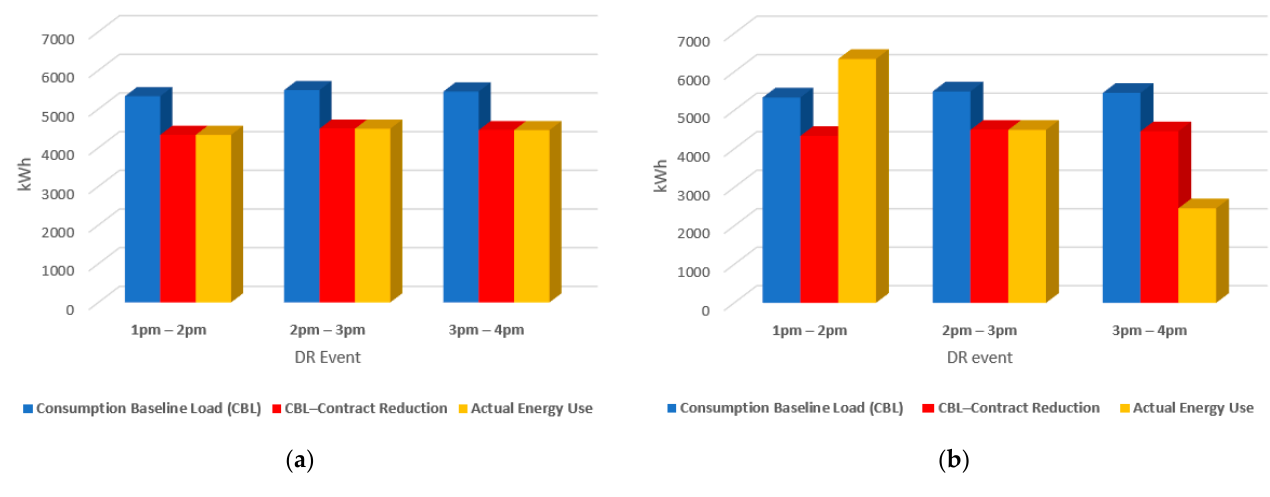
Figure 8. The examples of demand response evaluation: ( a ) The demand response with stable load adaptations. ( b ) The demand response with unstable load adaptations. Table 4. Compensation and